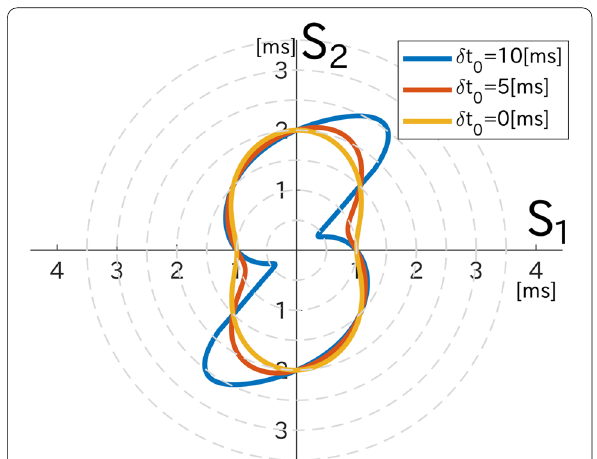
Fig. 10 Examples of the synthetic azimuthal pattern. Azimuthal variations of delays calculated by synthetic dataset are shown as examples. We showed three examples with 10, 5, and 0 ms of δ t 0 in Eq. (8). We provide A = 1, δ t 1 = 1[ms], δ t 2 = 2[ms] in Eqs. (8) and